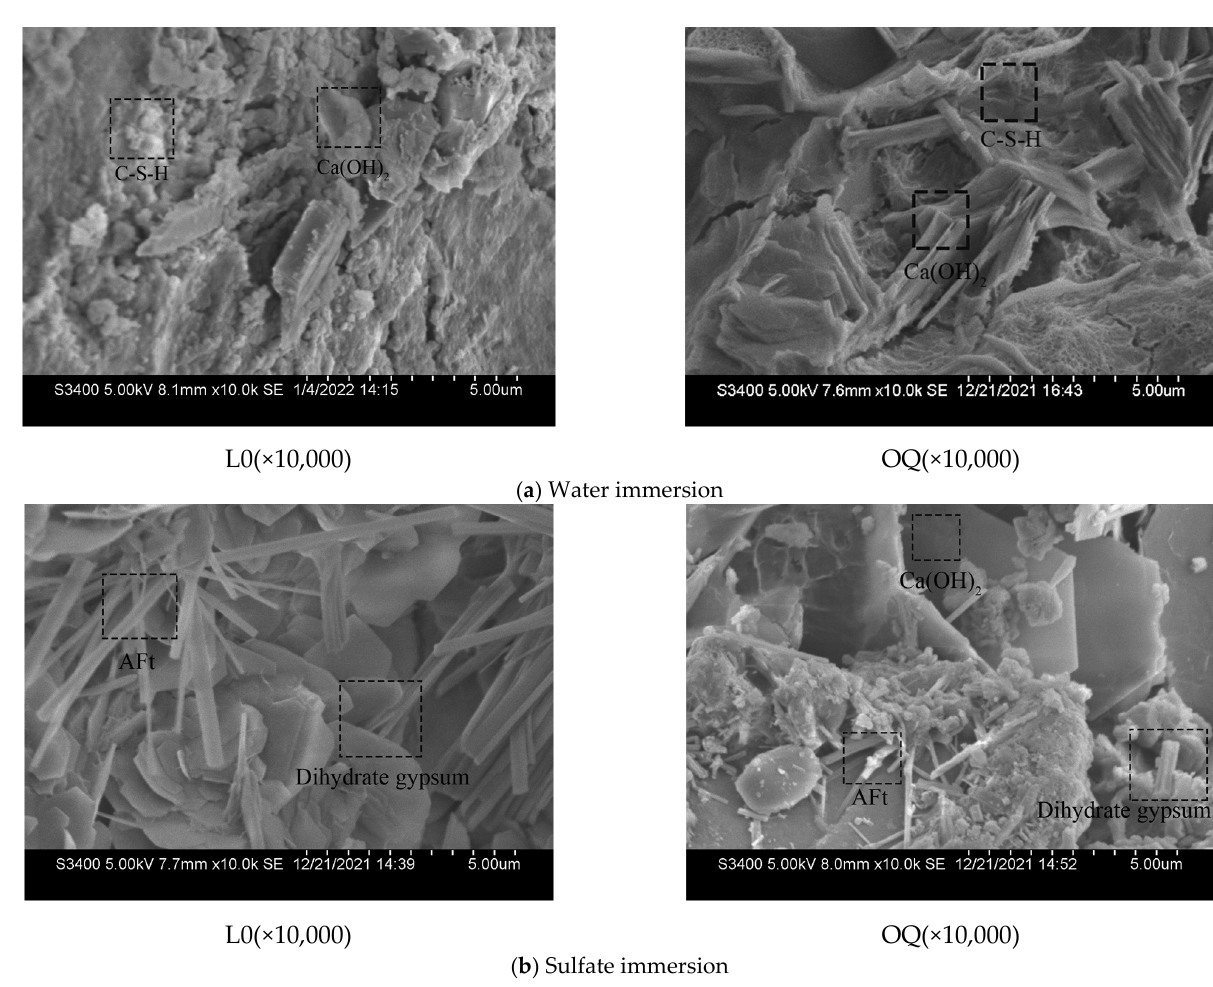
Figure 15. SEM photos of Group L0 and OQ’s erosion products.